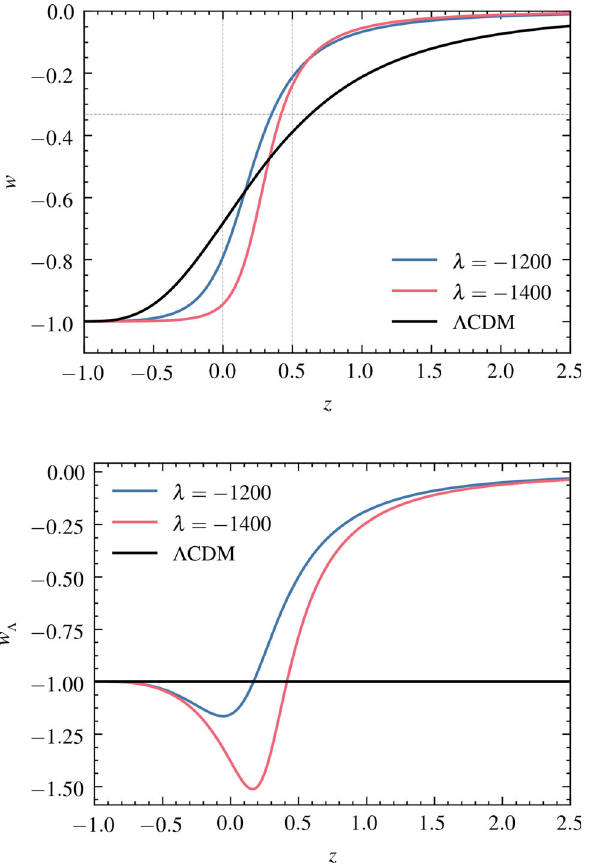
Fig. 4 Total equation of state ( w ) and dark energy equation of state ( w (cid:2) ) as a function of redshift ( z ) for different values of λ with standard Rényi HDE density (with (cid:12) m 0 = 0 . 315 and H 0 = 67 . 4 km/s/Mpc [78])